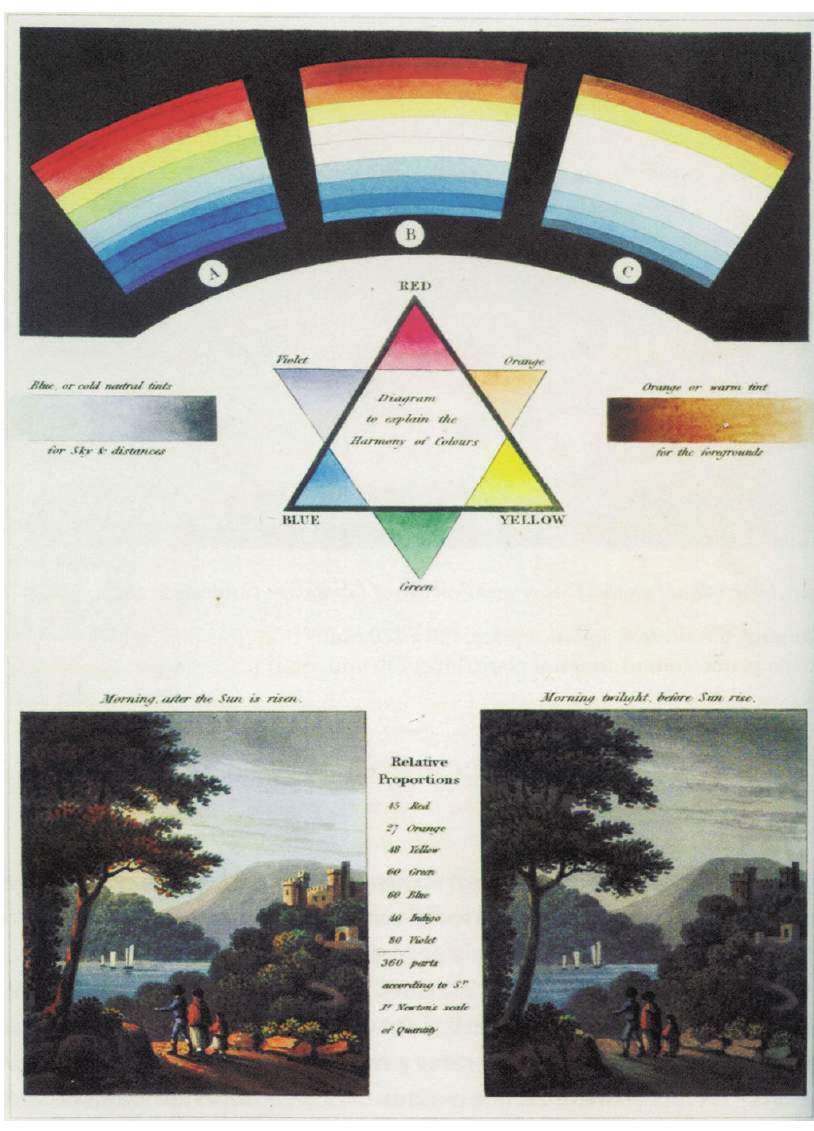
Figure 8. Repton, illustrations of experiment with watercolor shades to depict different daytime, aquatint page spread, Fragments on the Theory and Practice of Landscape Gardening (1816). Source : Research Library, The Getty